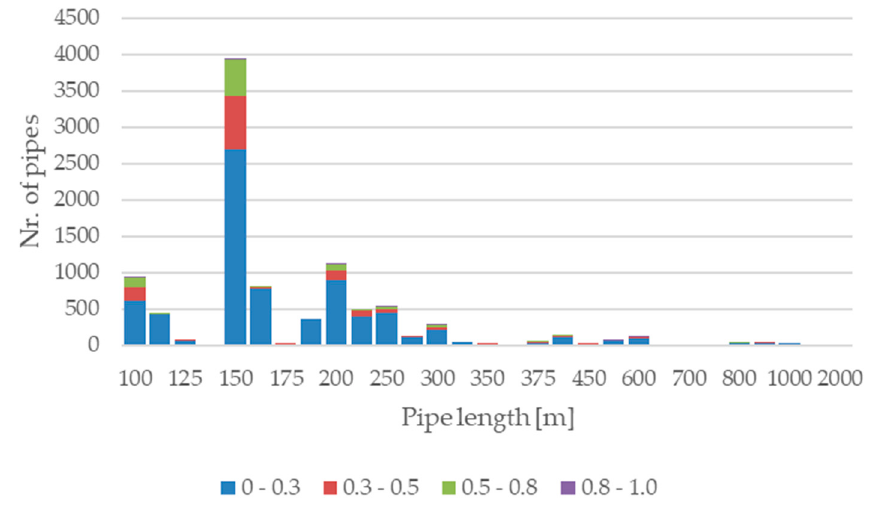
Figure A3. Number of pipes as a function of pipe diameter and pipe length.